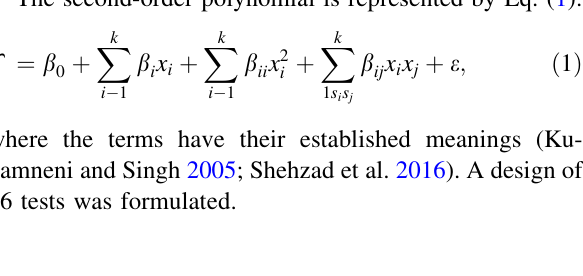
Contact time (min) Adsorbent dosage